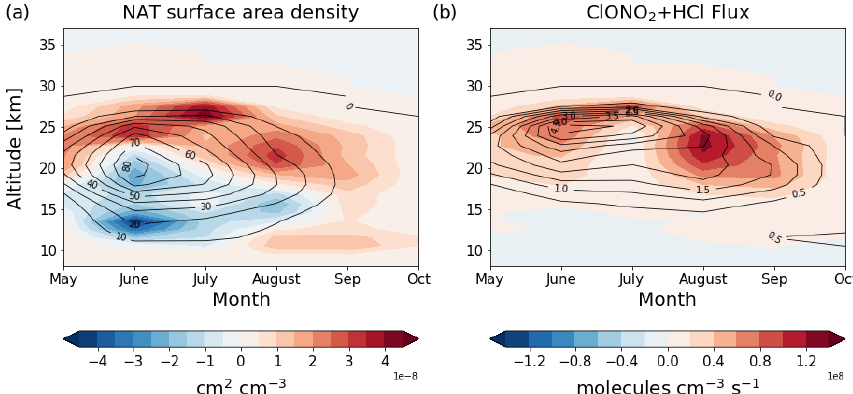
Figure 10. Altitude versus time plots of the differences in (a) NAT PSC surface area density ( × 10 − 8 cm 2 cm − 3 ; shading) and (b) the flux through the ClONO 2 + HCl reaction ( × 10 8 moleculescm − 3 s − 1 ; shading) between the perturbed run and the control run, averaged over the Antarctica Peninsula (over the region 76–64 ◦ S and 75–55 ◦ W), i.e. the difference between using T equal to either T UM − UKCA + (cid:49)T − (perturbation run with the parameterisation scheme on) or T UM − UKCA (control run with the parameterisation scheme off). Also shown in each panel are the respective values from the control simulation using a value of T equal to T UM − UKCA (contours).